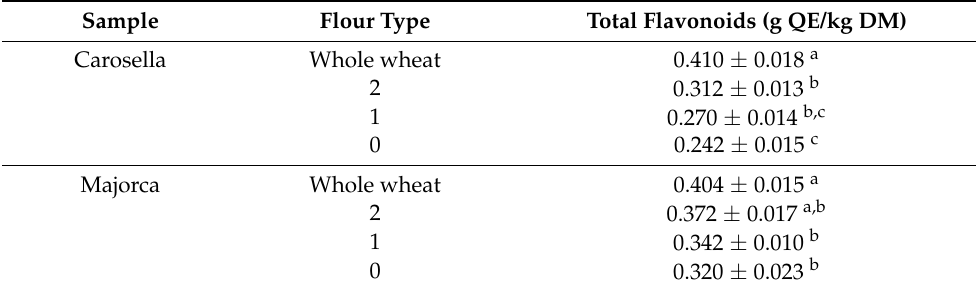
Table 3. Total flavonoid content of Carosella and Majorca samples.